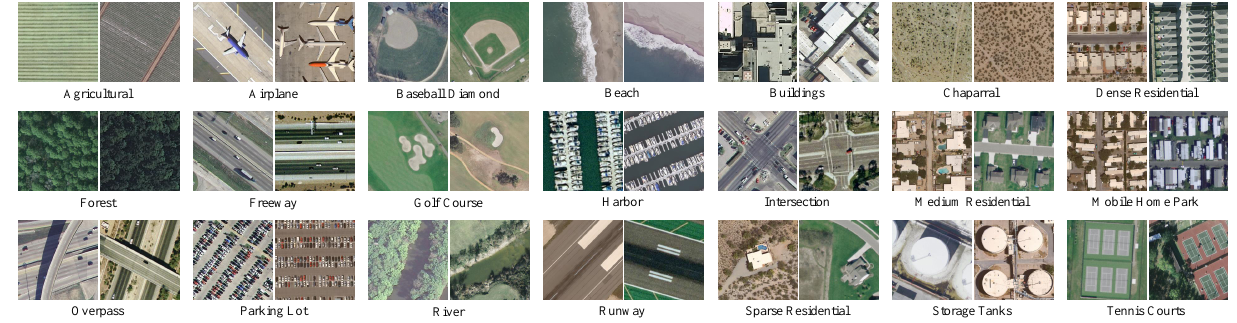
Figure 4. Two examples of each scene category in the UC Merced